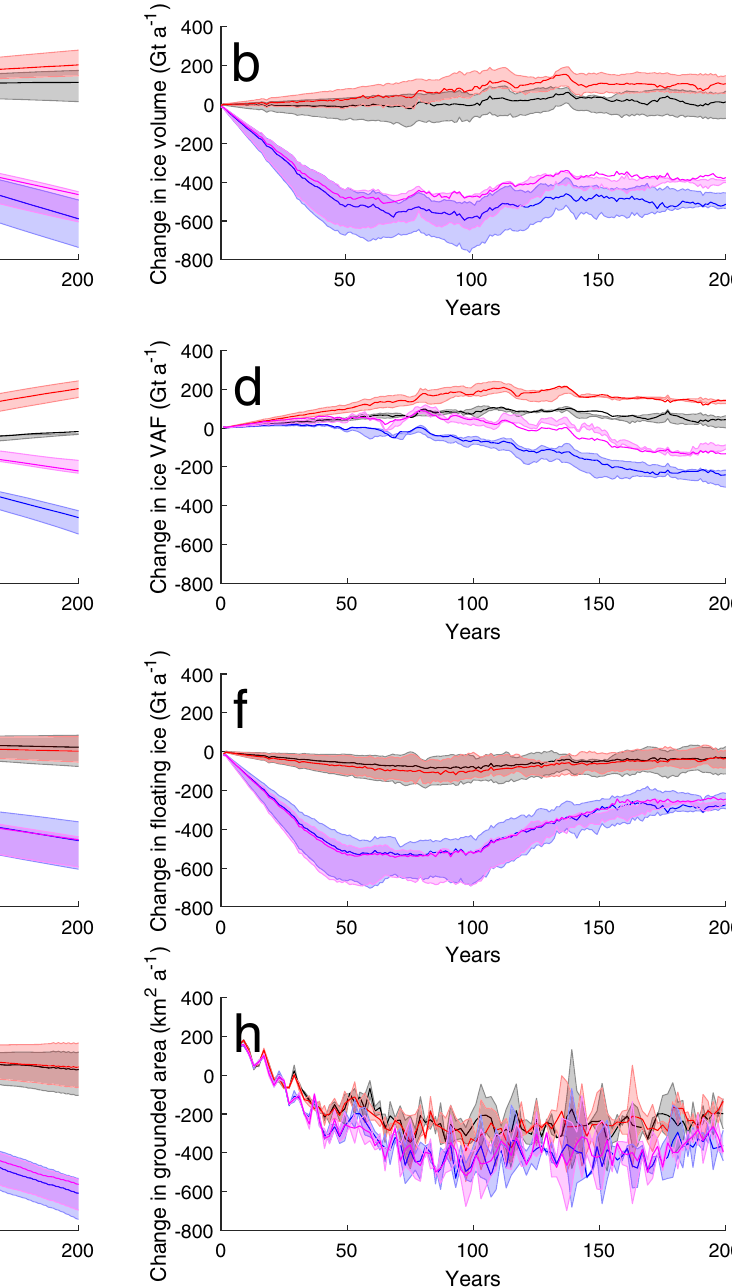
(RCP4.5-SW), red (RCP8.5-mCDW), blue (RCP4.5-mCDW) and magenta (RCP8.5- mCDW). The error envelopes are determined from additional simulations for each climate scenariocombining either the upper or lower estimates ofboth oceanand atmospheric forcing. Note that all results are shown relative to the reference run, and so are by de fi nition 0 at the start of the model